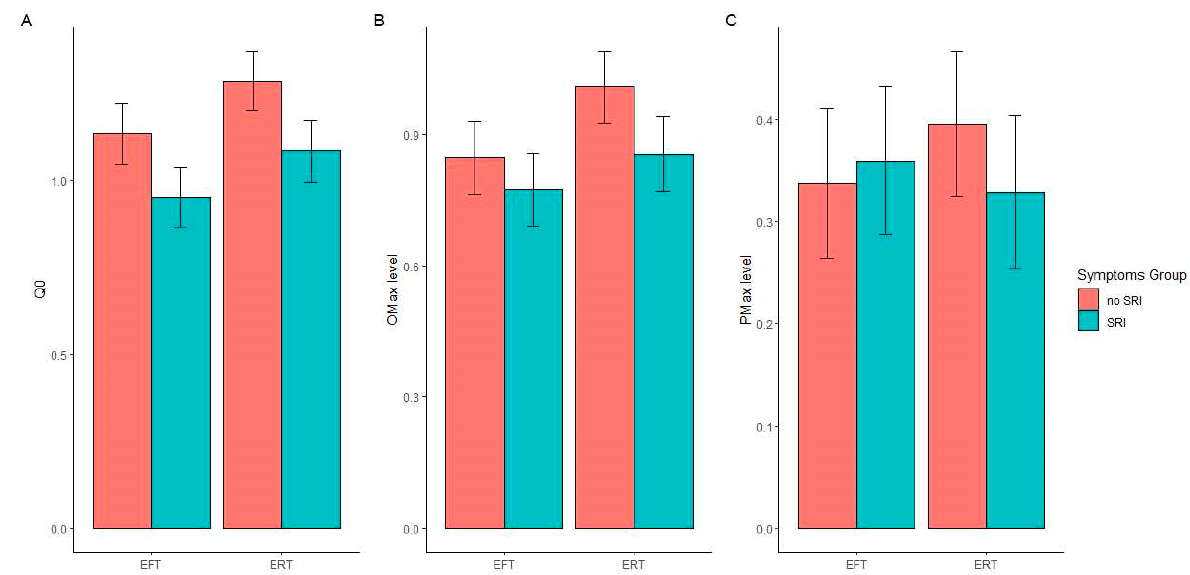
Figure 2. Mean covariate-adjusted log values of Q 0 (quantity of demand unconstrained by price; (panel ( A )), Omax (maximum expenditure; panel ( B )), and PMax (price at which maximum expendi- ture is observed; panel ( C )) in the cigarette purchase task in episodic future thinking (EFT) and smoking-related illness (SRI) groups. Higher values of each measure reflect greater demand for cig- arettes, with Q 0 reflecting amplitude of demand, PMax reflecting persistence of demand, and OMax reflecting both amplitude and persistence. Error bars represent standard error of the mean. A sig- nificant main effect of SRI was observed on Q 0 ( p < 0.050). No other main effects or interactions were significant (in all cases, p > 0.100).